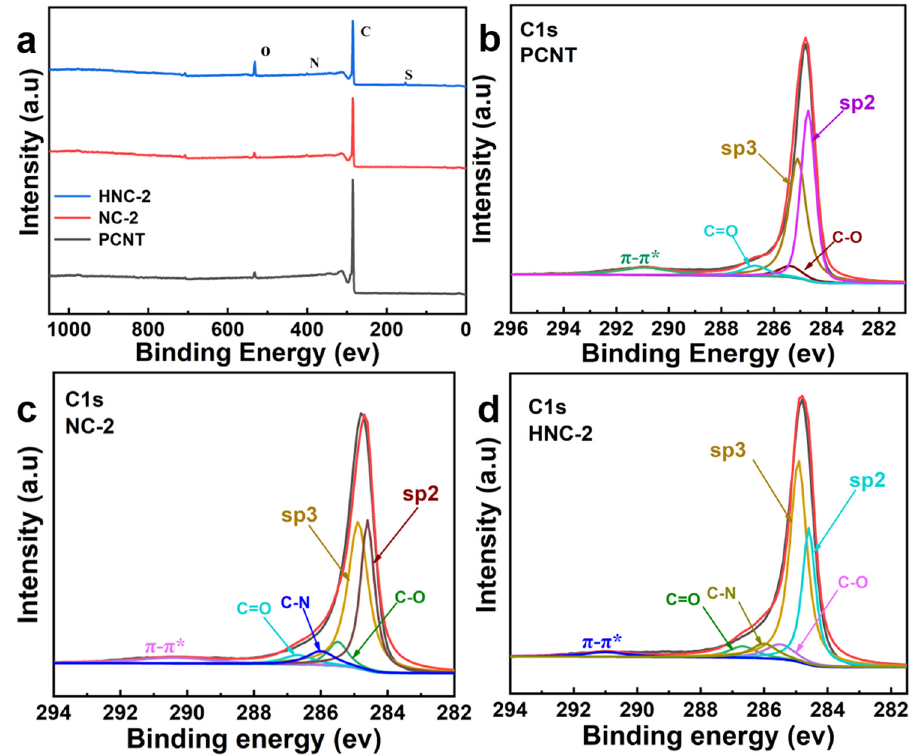
Figure 2: Spectra of PCNT, NC - 2, and HNC - 2: ( a ) total XPS and ( b – d ) C1s